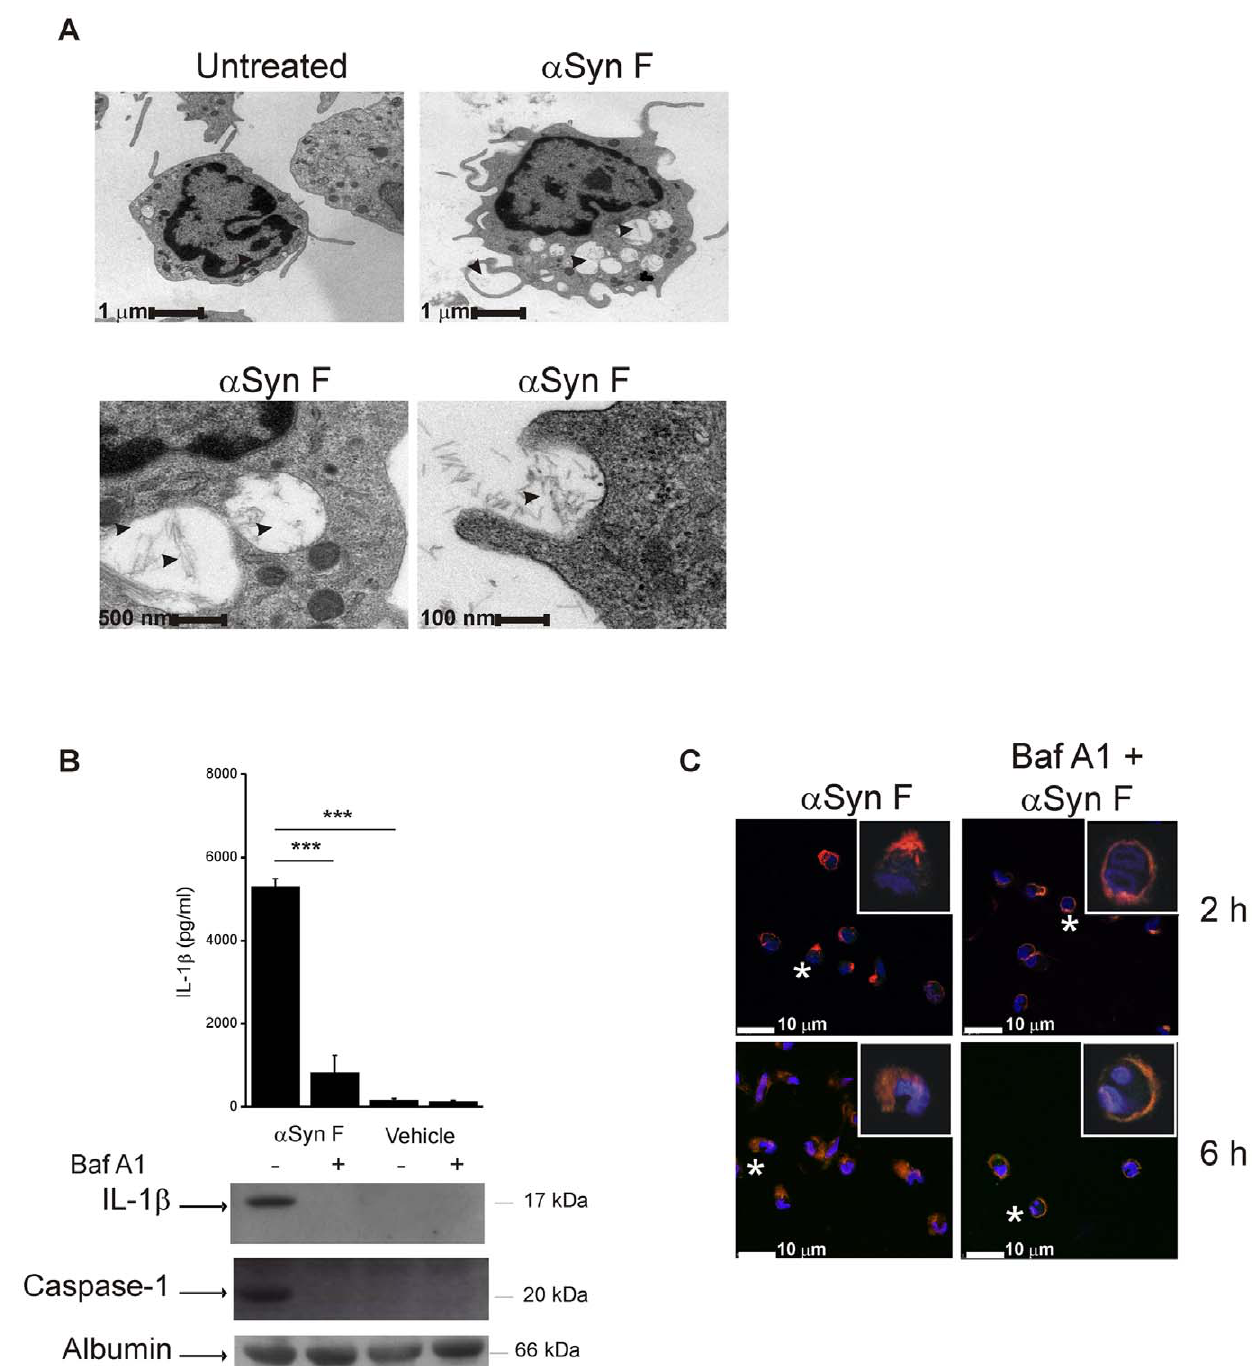
Figure 3. Phagocytosis of a Syn F is required for IL-1 b release. (A) Transmission electron microscopy of monocytes treated for 6 h with 40 nM a Syn F, or left untreated. For a Syn F-treated cells, three magnifications are shown (bars represent 1 m m, 500 nm and 100 nm). Pictures of 20–30 cells for each condition were kept and 3 representative cells are shown. Left bottom panel is the magnification of two a Syn-containing vacuoles of the cell in the right upper panel. Arrowheads indicate the fibrils. (B) Monocytes were pre-incubated for 30 min with 250 nM Baf A1, or left untreated, before being exposed for 6 h to a Syn F or vehicle. IL-1 b released into the culture supernatants was evaluated both by ELISA and immunoblot analysis. The same supernatants were assessed for the accumulation of active caspase-1 by immunoblot. Results are the mean 6 S.D. of 3 experiments conducted in duplicate with cell preparations obtained from 3 different donors. The immunoblot is from one representative donor. *** p , 0.001. (C) Confocal microscopy of monocytes incubated with 250 nMBaf A1 before and during the exposure for 2 or 6 h to a Syn F. Red staining corresponds to rhodamine-labelled a Syn F, while the Hoechst blue staining labels nuclei. White asterisks indicate the cells of which a magnification is shown (white square).